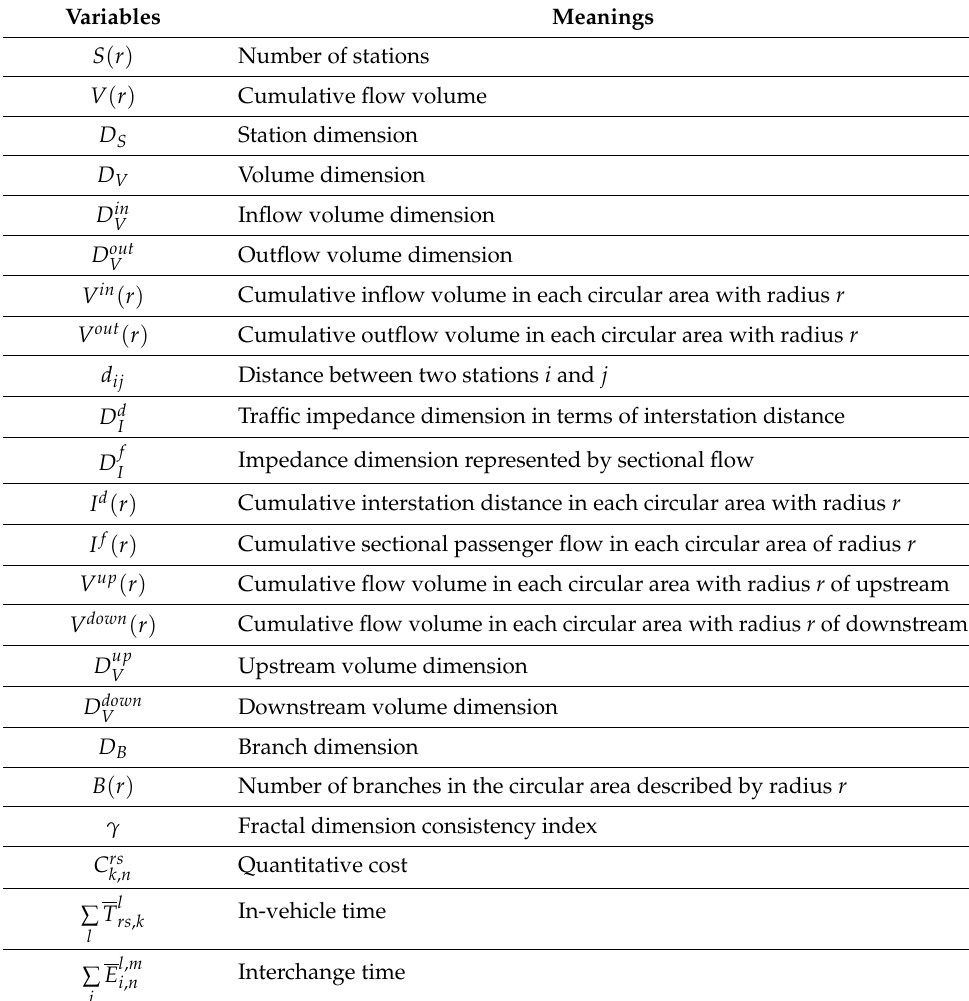
Table A1. Summary of all